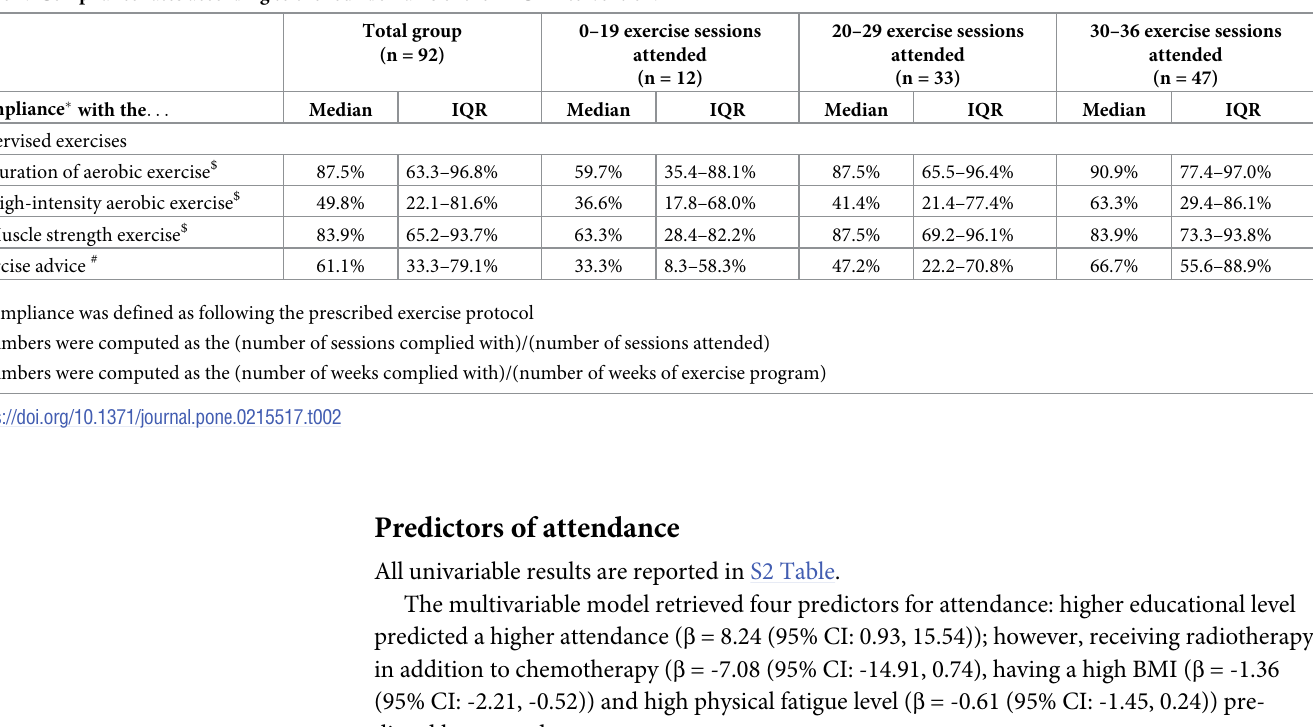
Table 2. Compliance rates according to the four domains of the PACT